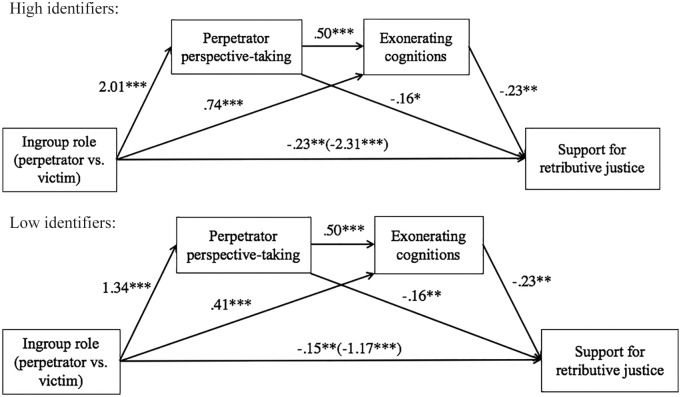
Moderated serial mediator models for high and low identifiers (Study 2).Note. All path coefficients are unstandardized.